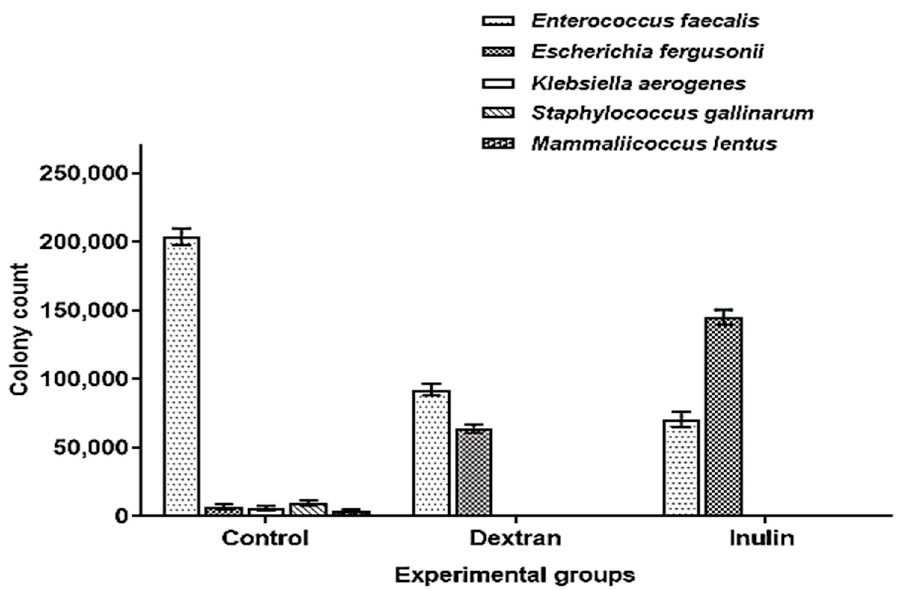
Figure 6. Comparative analysis of intestinal microbiota in different treatment groups of mice. Table 4. Effect of dextran and inulin supplemented diet on intestinal microbiota of mice. Treatment Groups * Microorganisms